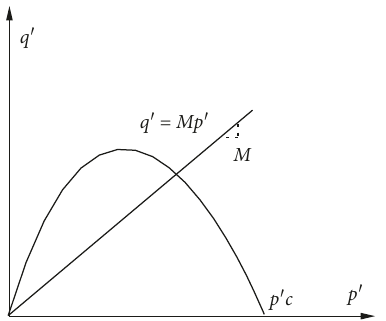
Figure 1: The yield curves of modified Cam-clay model.